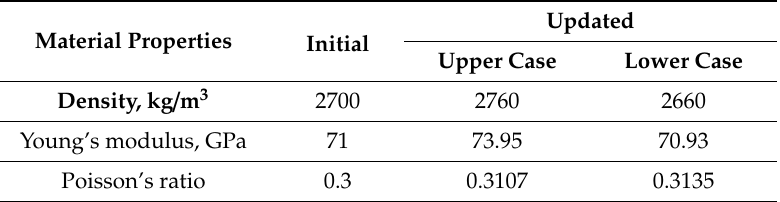
Table 4. Results of the FE model update.